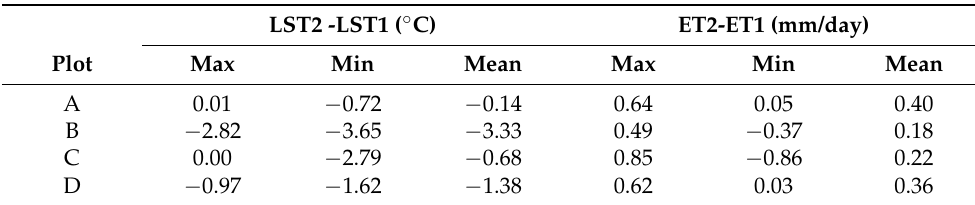
Table 3. Maximum, minimum, and mean difference in tree temperature (LST) and evapotranspiration (ET) by pistachio trees between the first (1) and second (2) imaging dates after foliar application of gypsum on the first date (plot A only) and of gypsum again, gypsum, NAX-95 (calcium-based suspension coating), and sulfur in plots A, B, C, and D, respectively, on the second date. LST2 -LST1 ( ◦ C) ET2-ET1 (mm/day) Plot Max Min Mean Max Min Mean A